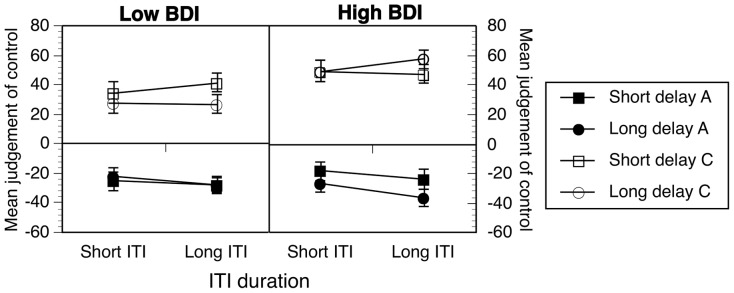
Effects of ITI length and delay duration on ratings of negative (50/100) contingencies.Data are combined across Experiments 3a and 3b. Error bars correspond to the standard error of the mean. A  =  action ratings, C  =  context ratings.